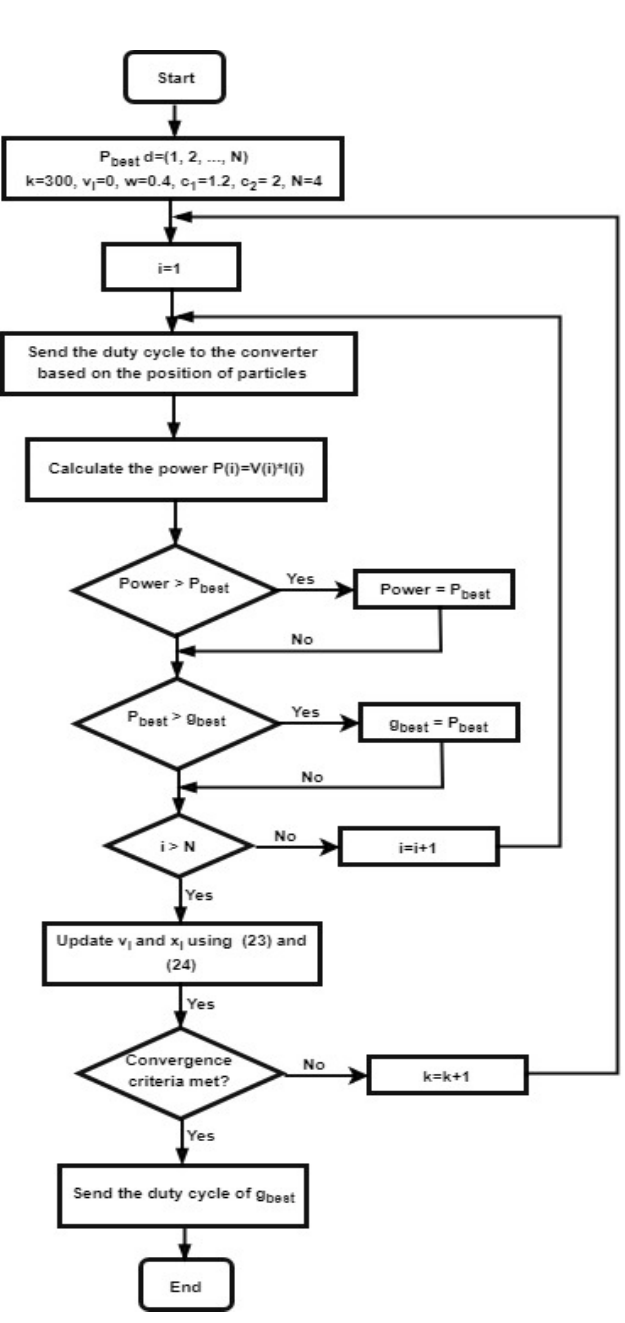
Figure 5. Output membership function.